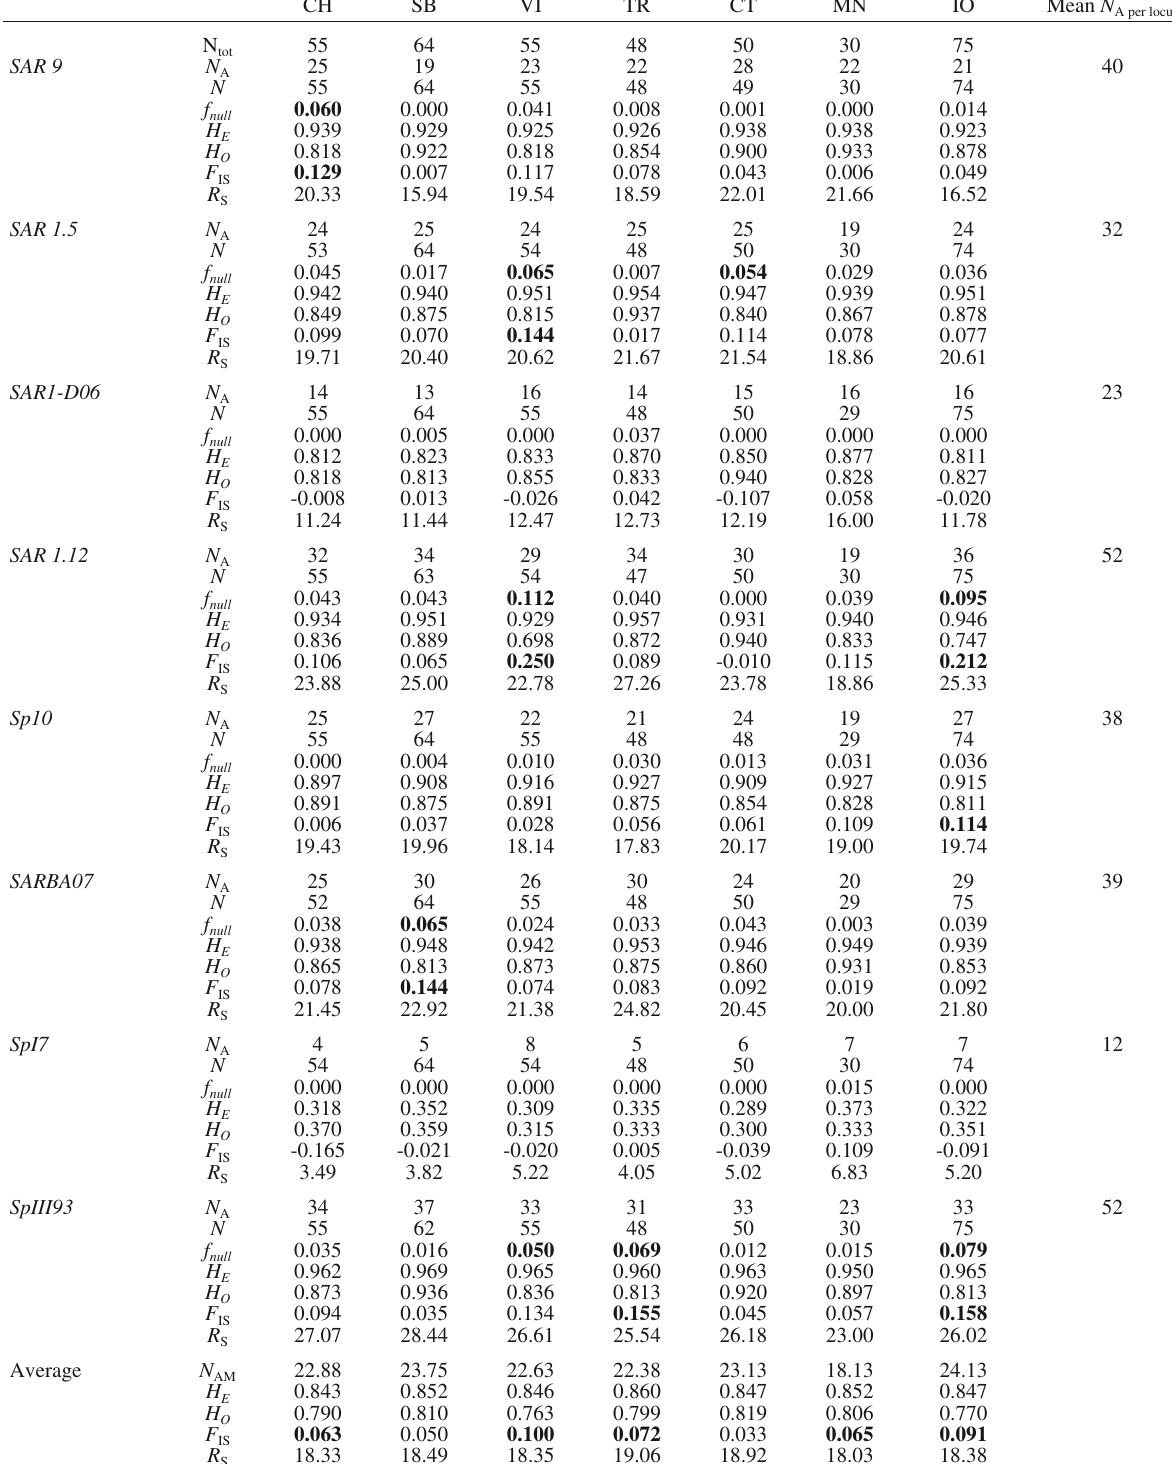
Table 3. – Summary statistics of genetic variability at eight microsatellite